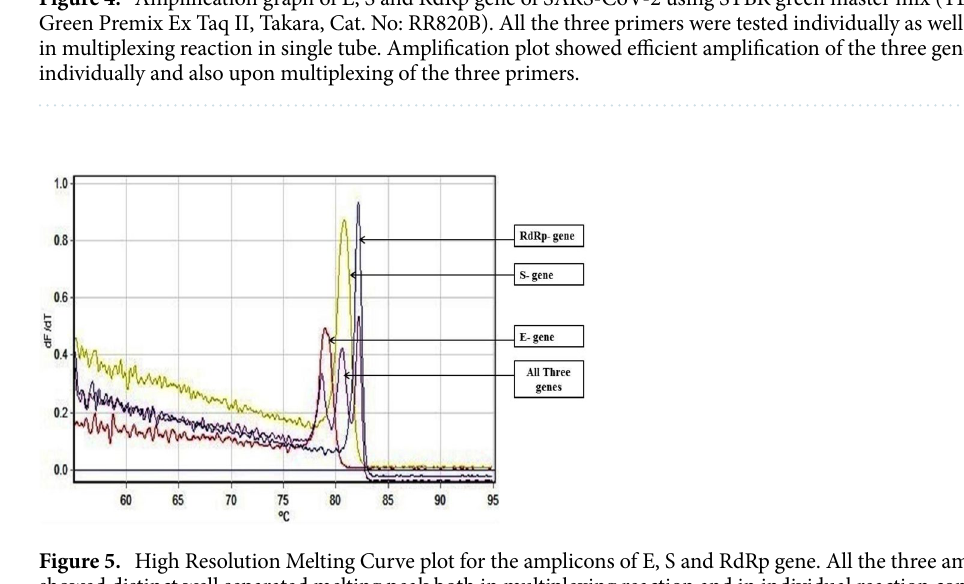
Figure 5. High Resolution Melting Curve plot for the amplicons of E, S and RdRp gene. All the three amplicons showed distinct well separated melting peak both in multiplexing reaction and in individual reaction